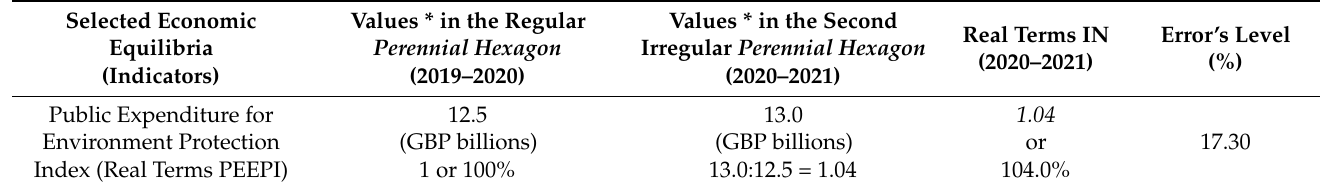
Table 5. The value of the sixth essential MID indicator adequate in a “ perennial hexagon ”, based on UK data, detailed as IN for “ 6-gon ” GAIN.